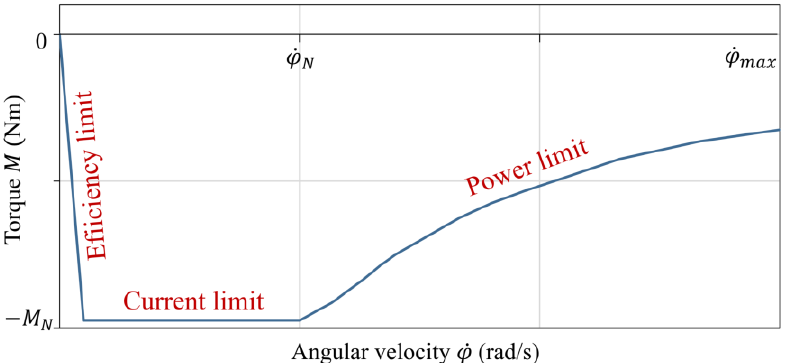
Figure 1. Torque – angular velocity characteristic for drive machines in regeneration mode according to [5].